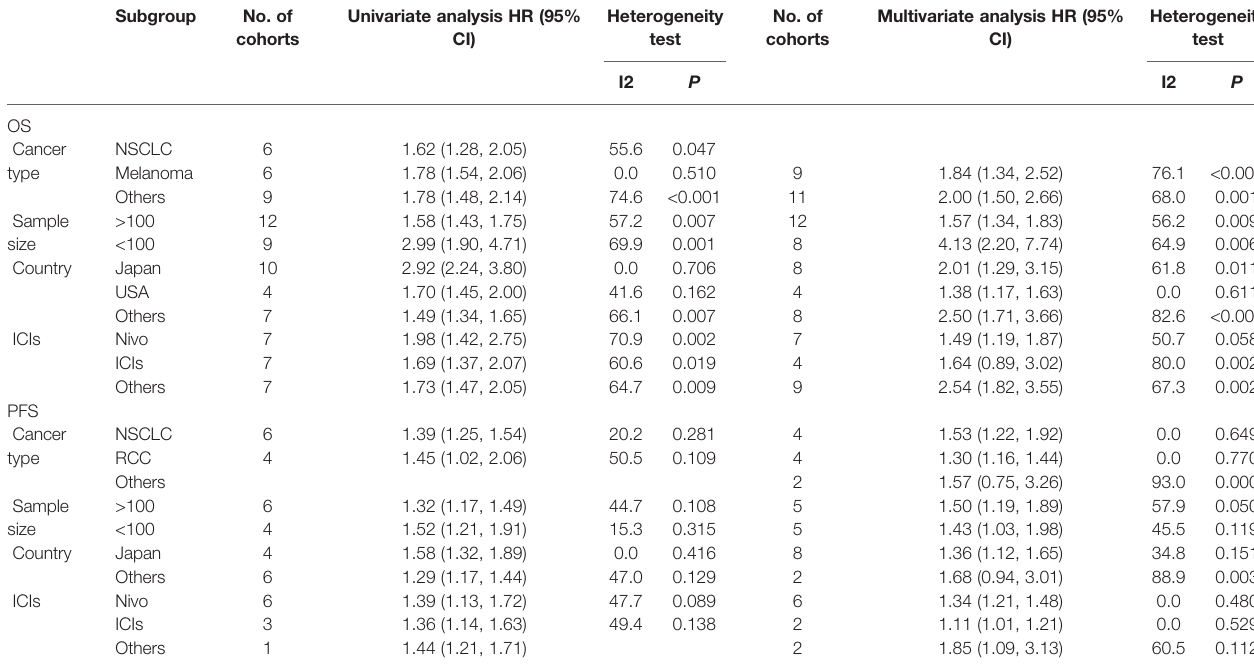
TABLE 2 | Subgroup analyses.